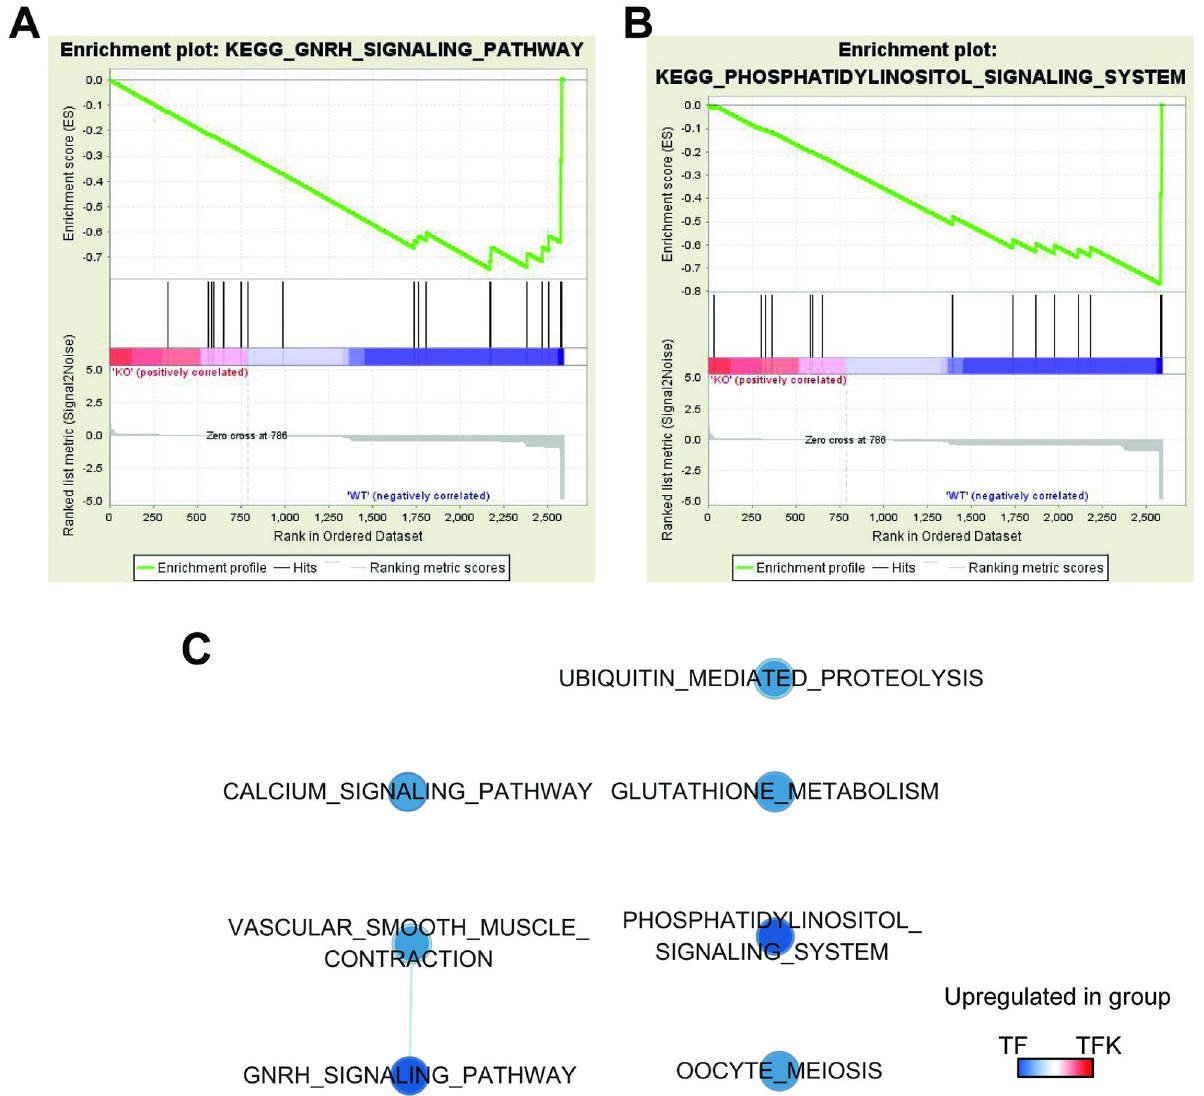
Fig 6. Gene set enrichment analysis (GSEA) on all the identified proteins in TF and TFK mice. (A-B) The enrichment plots (profile of the running ES Score & positions of gene set members on the rank ordered list) for gene sets, GnRH signaling pathway (A) and phosphatidylinositol signaling system (B), were shown. (C) The enrichment map for 7 enriched gene sets at FDR < 50% and nominal p -value < 0.05 was drawn in Cytoscape. The blue color of nodes represents the pathways upregulated in TF mice.